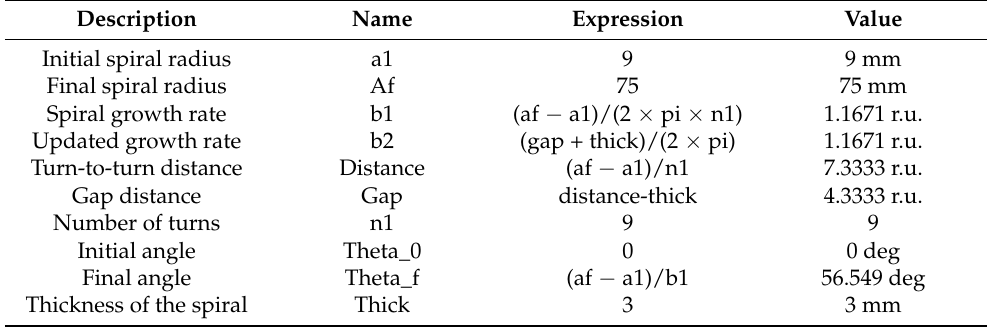
Table 1. System of equations and parameters for simulation of coil geometry in COMSOL